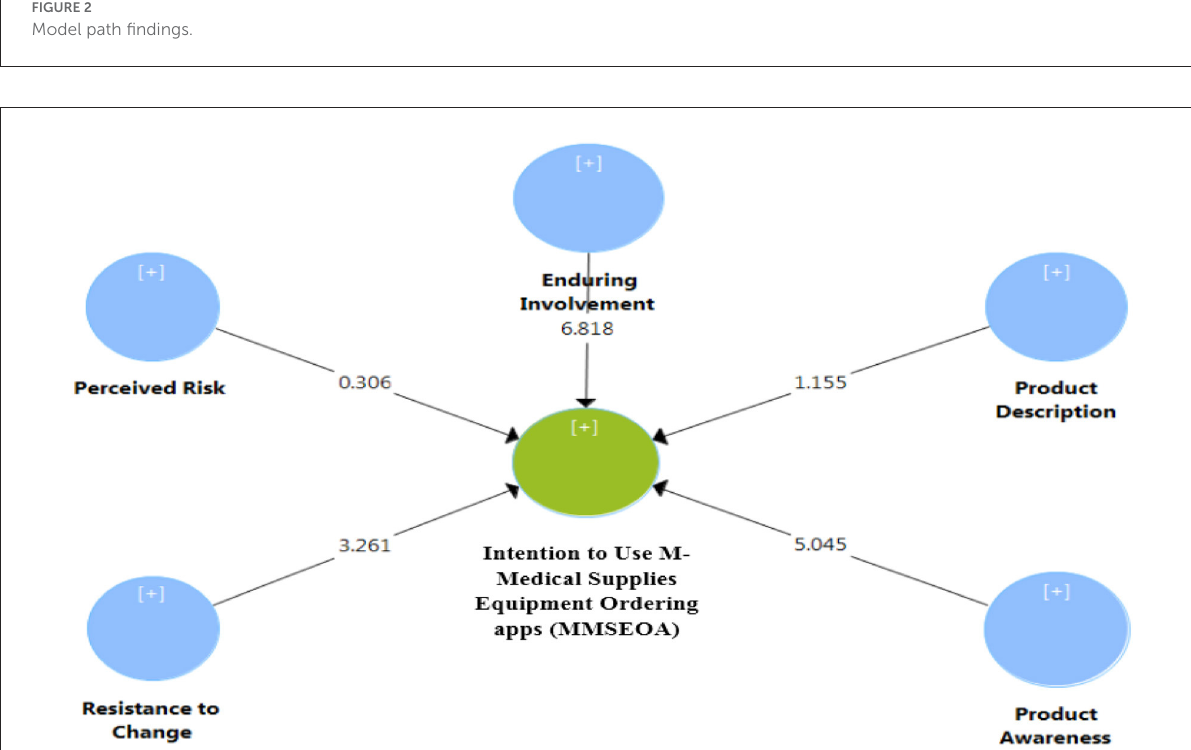
FIGURE3 Model path importance